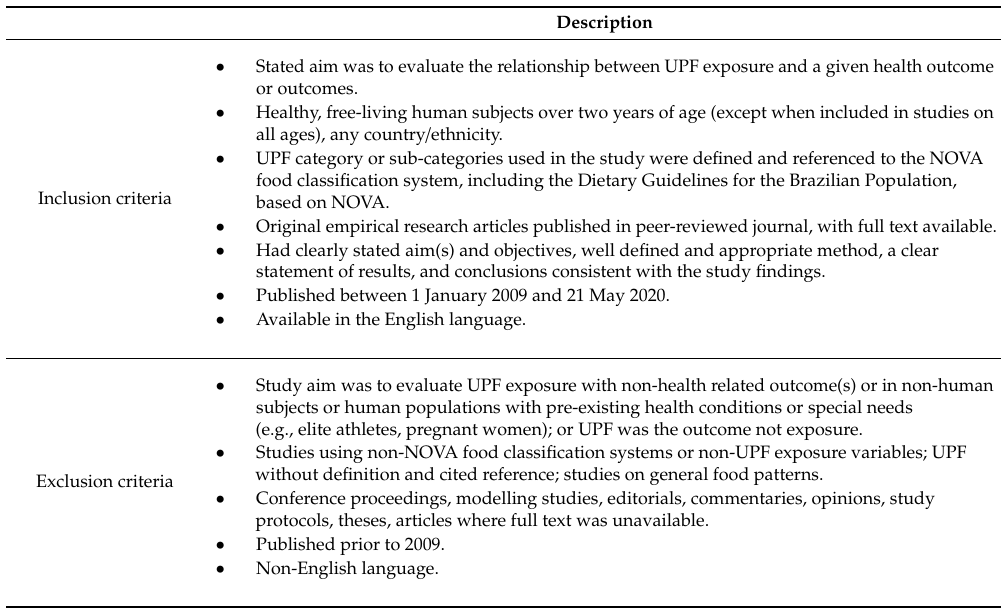
Table 1. Inclusion and exclusion criteria used for screening